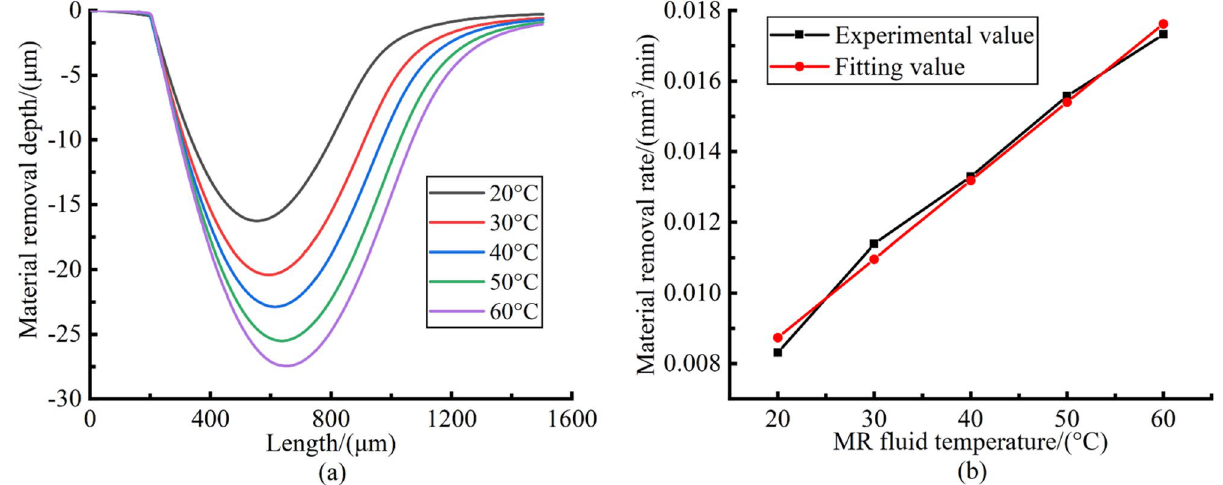
Figure 11. The results of verification experiment. ( a ) The section contour of the polished pit; ( b ) The change curve of material removal rate.